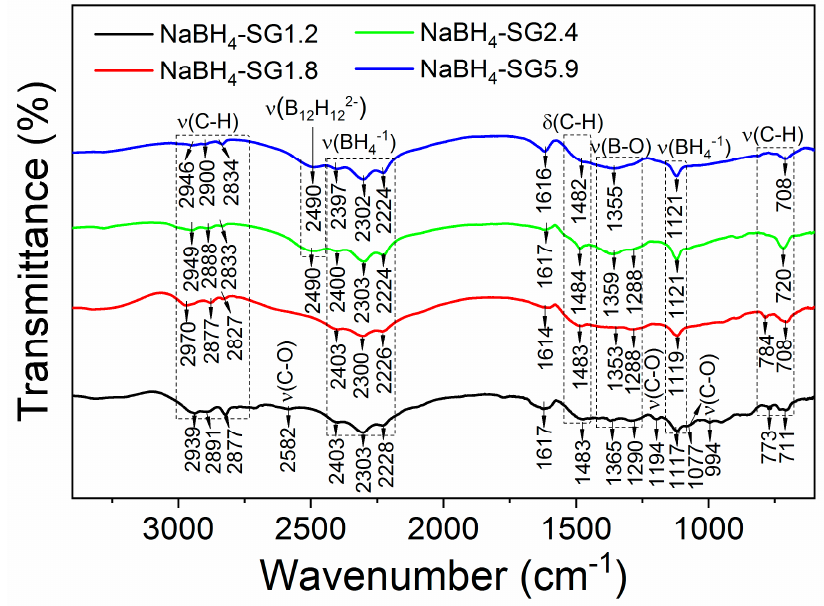
Figure 3. FTIR spectra the as-synthesized NaBH 4 via solid-gas interaction.